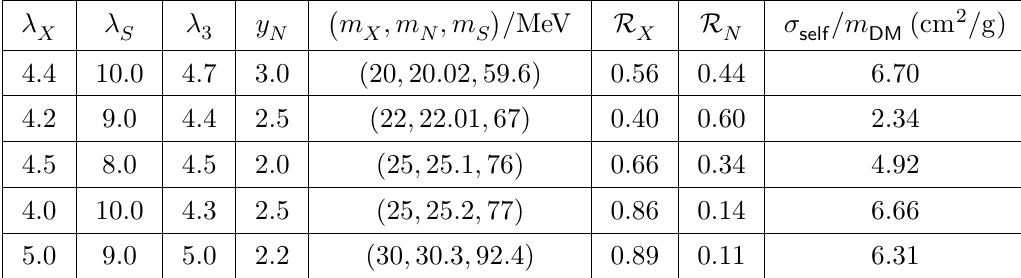
Table 2 . The benchmark points in the r SIMP model for r